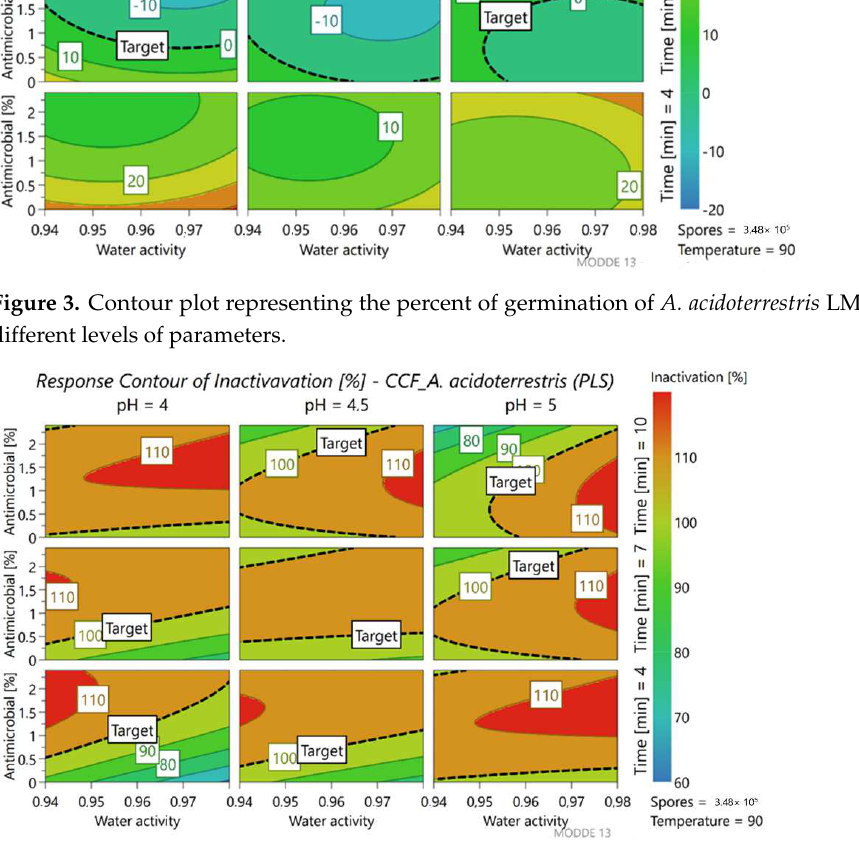
Figure 5. Percentage variation of germination ( a ) and inactivation ( b ) of C. pasteurianum LMG 3285 spores after exposure to DoE conditions.